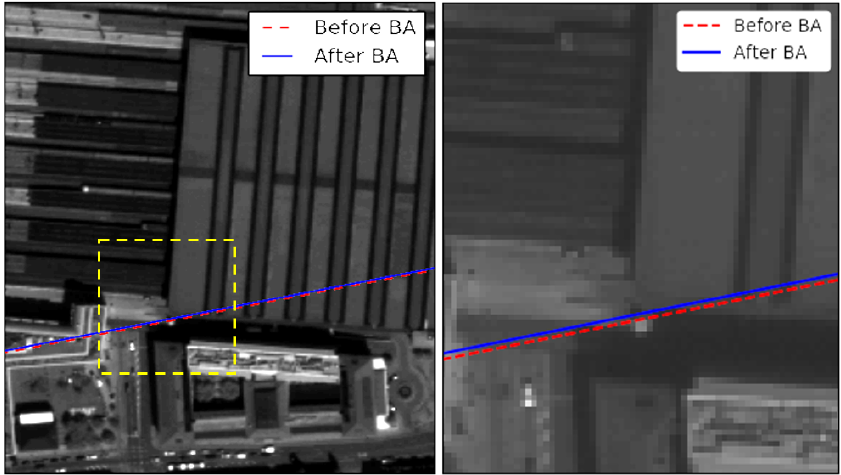
Figure 6. The epipolar line location before (dashed red) and after (blue) the block adjustment on WorldView-2 image